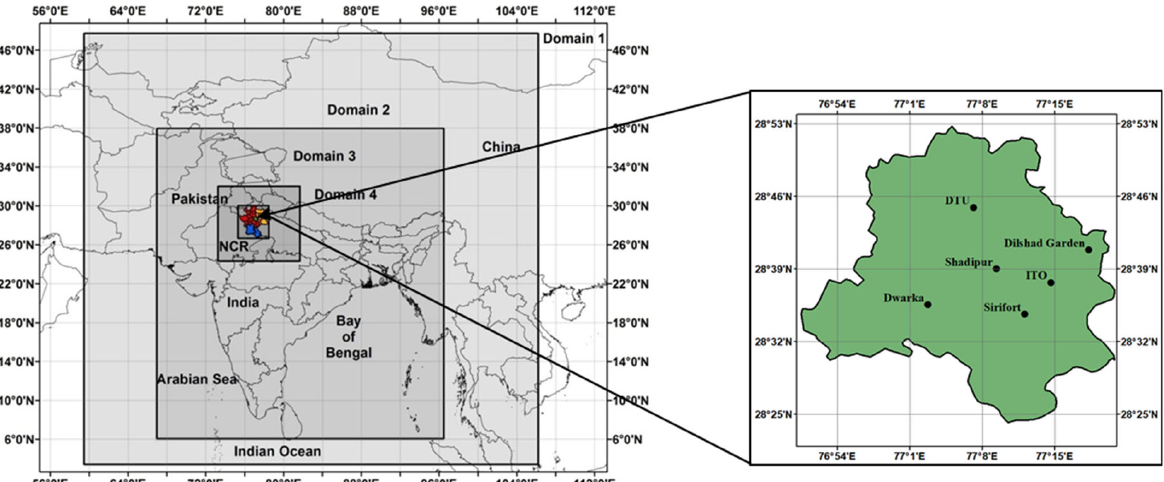
Figure 1. Simulation domains ( left panel ) covering (i) Asia (54 km resolution) as domain 1, India (18 km resolution) as domain 2, parts of North India (6 km resolution) as domain 3 and domain 4 enveloping National Capital Region (2 km resolution) along with Delhi map ( right panel ) indicating location of monitoring stations of Central Pollution Control Board (CPCB).